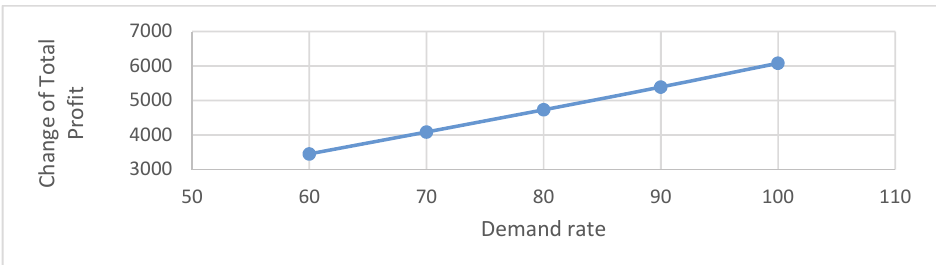
Fig. 6. Effect of demand rate on total profit of the inventory system